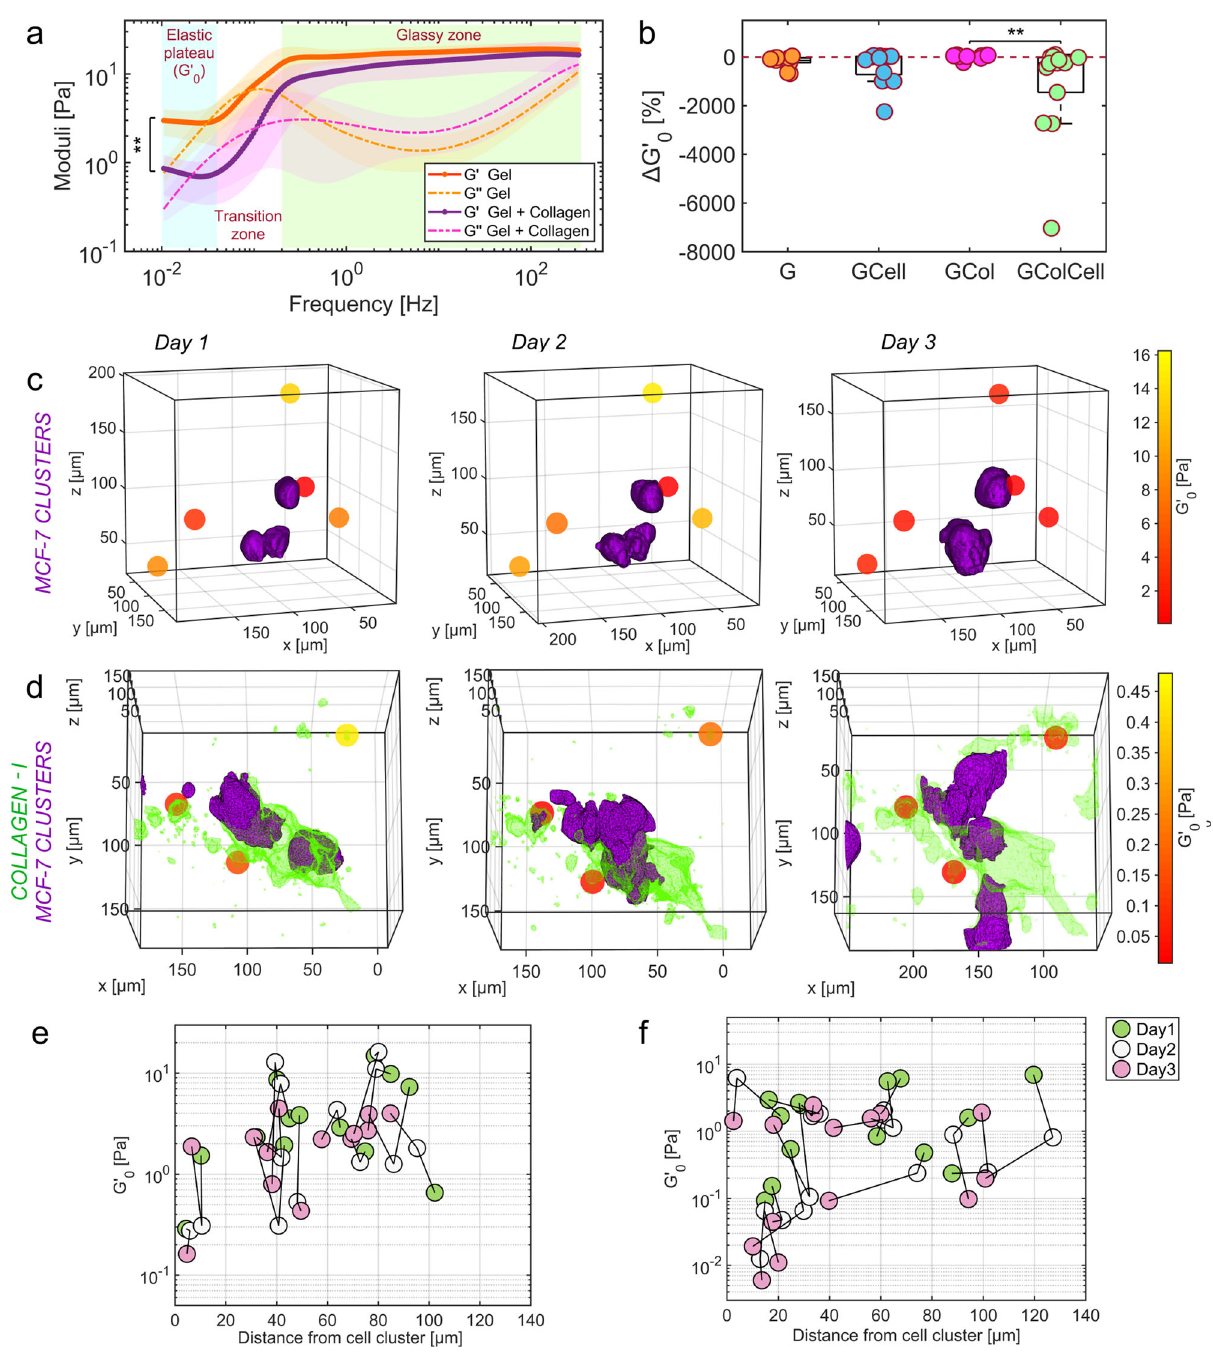
Fig. 5 Local stiffness measured in live 3D cell cultures with different compositions. a Complex moduli of plain gel in orange and gel supplemented with collagen in purple at day 1 ( n = 11 for each conditions averaged with 95% con fi dence intervals shown as shaded regions). b Proportional change in the height of the low frequency elastic plateau G 0 (Eq. 4 in Methods) at individual bead probes over three days of observation in plain gel (G) n = 11, gel with 0 collagen (GCol) n = 11, gel seeded with cells (GCell) n = 13 and gel with collagen and cells (GColCell) n = 14. The dashed line represents no change, negative values indicate more compliant gels. c , d Biomechanical maps produced by OptoRheo of MCF-7 clusters expressing tdTomato (shown in purple) encapsulated in hydrogels and d . MCF-7 clusters from the same cell line in hydrogel supplemented with collagen I labelled with Cy5 (shown in green) monitored over three days. Spheres depict microsphere probes (not to scale) assigned a colour to re fl ect the local stiffness ( G 0 ). e , f Spatio-temporal 0 changes in G 0 values with relative distance from the edge of the cell clusters in gel in the absence ( e ) and presence ( f ) of collagen over three 0 combined with microrheology measurements to map the chan- The curves of the elastic ( G 0 ð ω Þ ) and the viscous ( G 00 ð ω Þ ) ging biomechanical properties to the changing morphology of the moduli of all the hydrogel preparations show a pattern sample, at the microscale. This approach was used to compare characteristic of viscoelastic polymer gels 39 with a rubbery elastic (where G 0 ð ω Þ > G 00 ð ω Þ ) at low frequencies transitioning four different complex systems made of hydrogels with and plateau G 0 0 without (i) collagen and (ii) cells. to a high frequency glassy state (Figs. 3e, 5a). Environmental